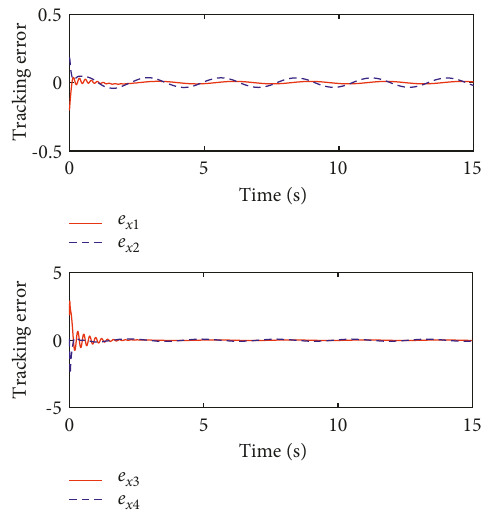
Figure 19: Tracking errors of q